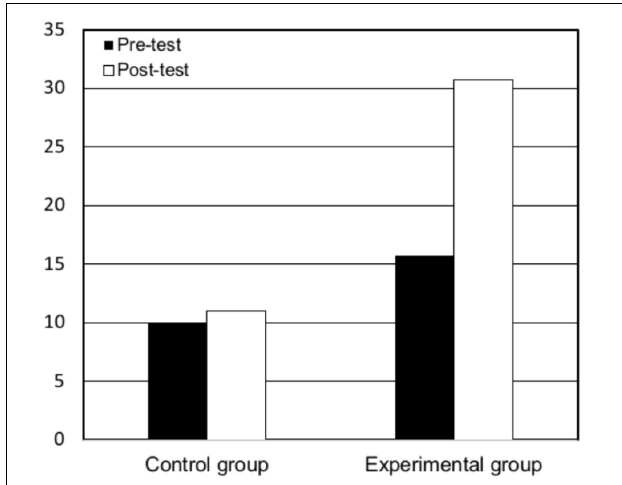
FIGURE 1 | Pre- and post-test mean of coverage of critical memories by condition.